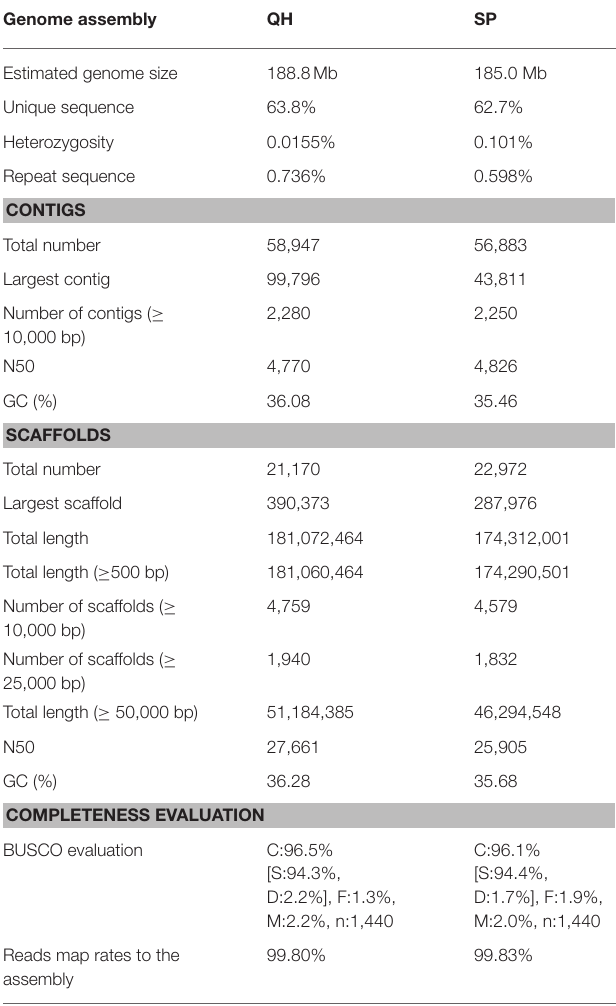
TABLE 1 | Summary of sequencing reads and statistics for genome assembly and